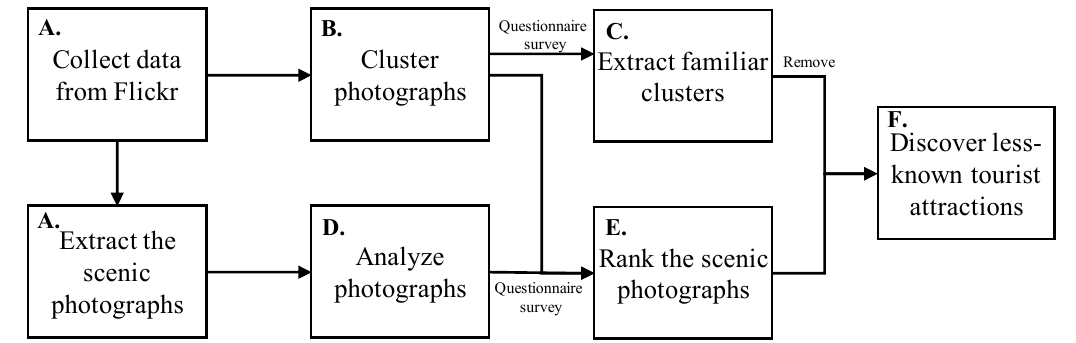
Figure 1. Overview of workflow. Red blocks represent updated parts used for this study.